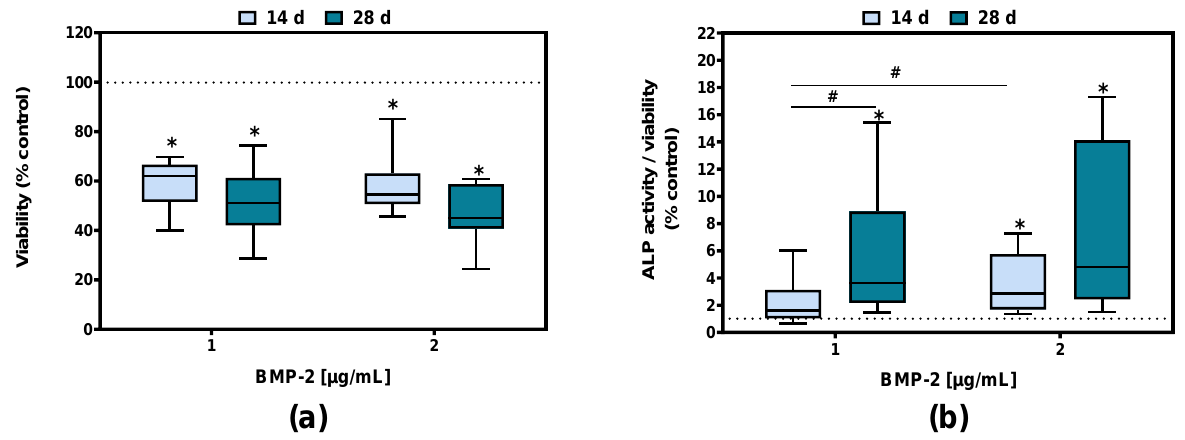
Figure 1. Viability ( a ) and ALP activity related to viability ( b ) of human pre-osteoblasts following BMP-2 exposure to 1 or 2 µg/mL after 14 or 28 days. The data are depicted relative to the control values. Results are depicted as medians, interquartile ranges, minimum, and maximum with * p < 0.05 compared to the control and # p < 0.05 compared to different time points or concentrations using two-way ANOVA with Bonferroni’s multiple comparisons test (n ≥ 7).